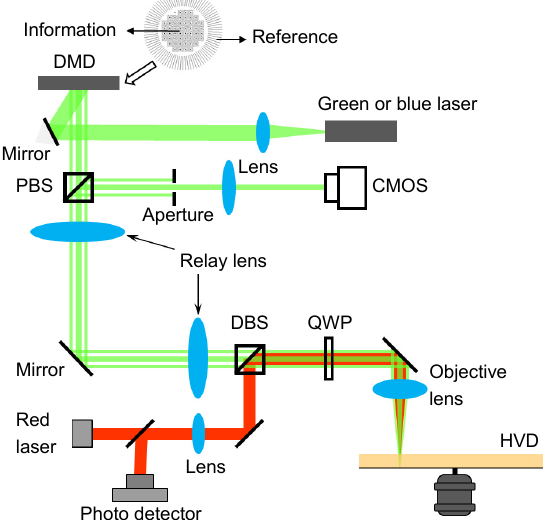
Fig. 3 | Optical con fi guration of CHDSS. Photo detector and red laser are utilized to servo control and locate holograms. QWP: quarter wave plate; HVD: holographic versatile disc; DMD: digital micro mirror device, one kind of SLM; PBS: polarized beam splitter; DBS: dichroic beam splitter.